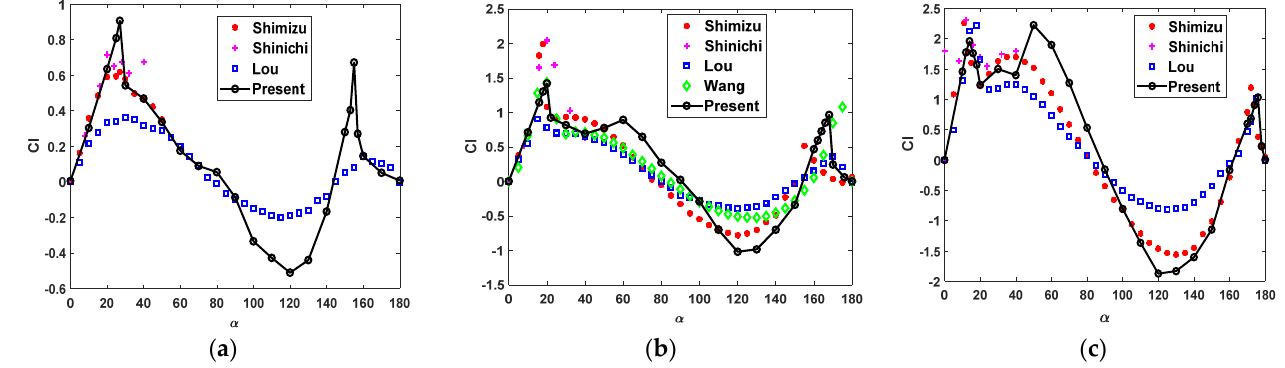
Figure 5. Comparison of the variation of mean lift coefficients with wind attack angle: ( a ) 0.25D, ( b ) 0.5D, and ( c ) 1.0D.